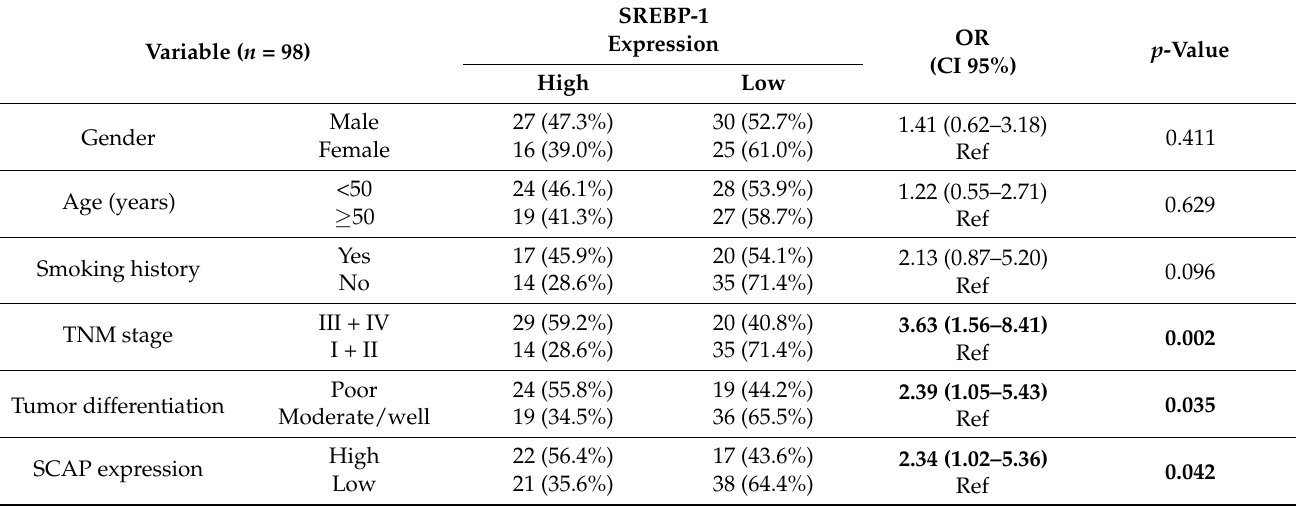
Table 1. Association between SREBP-1 and clinicopathological features of NSCLC